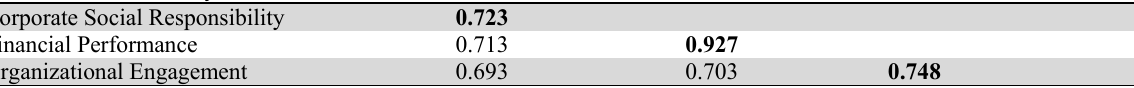
Discriminant Validity